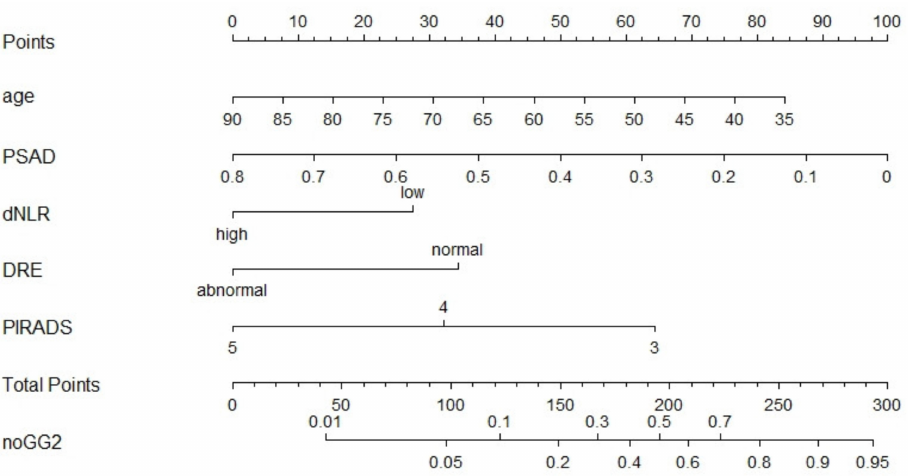
Figure 2. Pre-biopsy nomogram based on multivariable logistic regression model with dNLR predict- ing benign pathology or GG1 disease in patients with PI-RADS ≥ 3 lesions undergoing systematic and targeted biopsy. Instructions for physicians: Locate the patients status on the corresponding axis. Draw a straight line to determine how many points the patients should receive for each variable. Sum the points received and locate the number on the total points axis. Draw a line down from total points to the noGG2 axis.